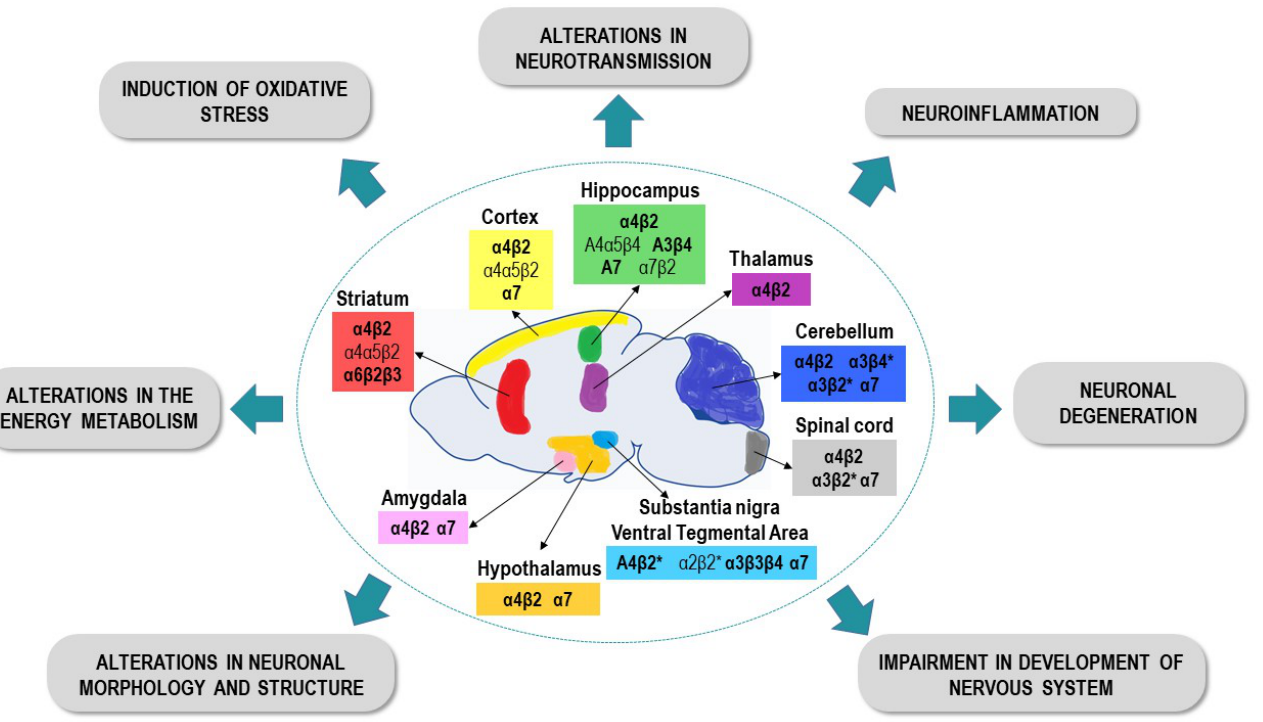
Figure 3. Distribution of the nAChR subtypes identified in some regions of the rodent CNS, and the main toxic effects observed after exposure to NNs pesticides in the rodent CNS.